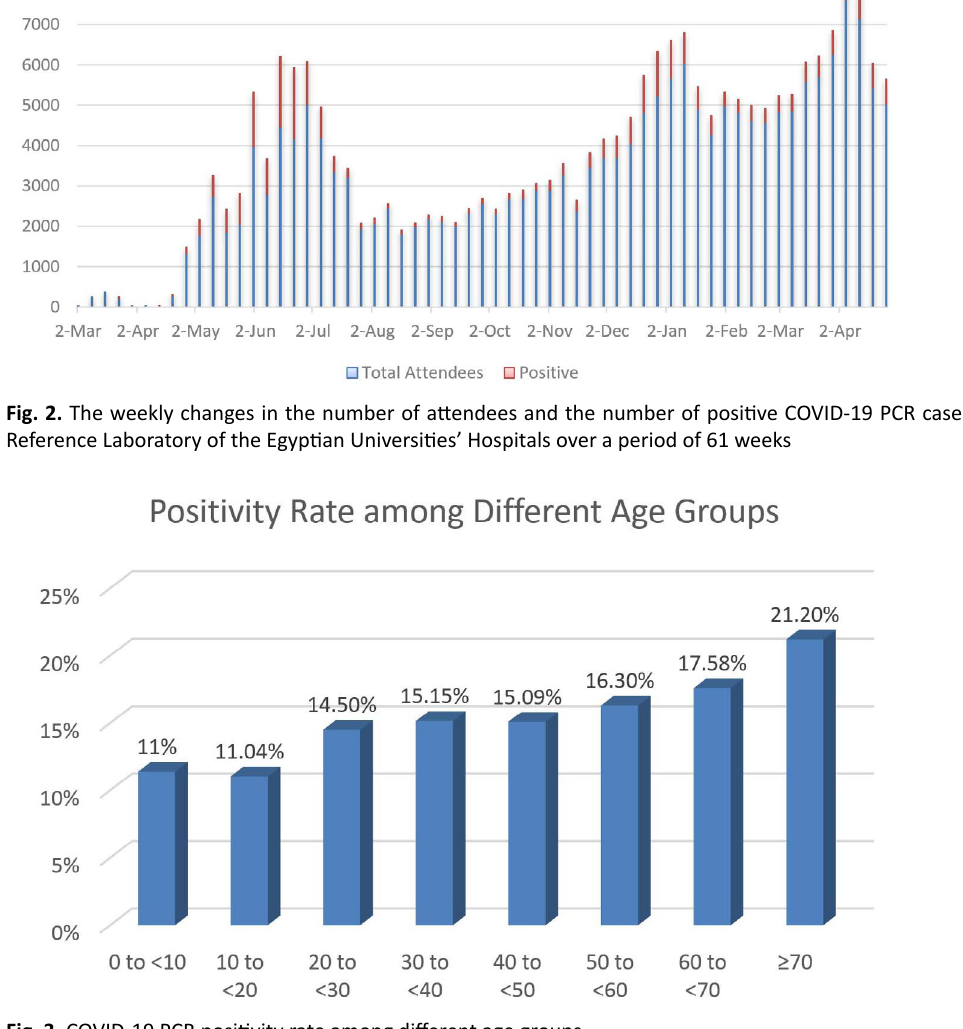
Fig. 3. COVID-19 PCR positivity rate among different age